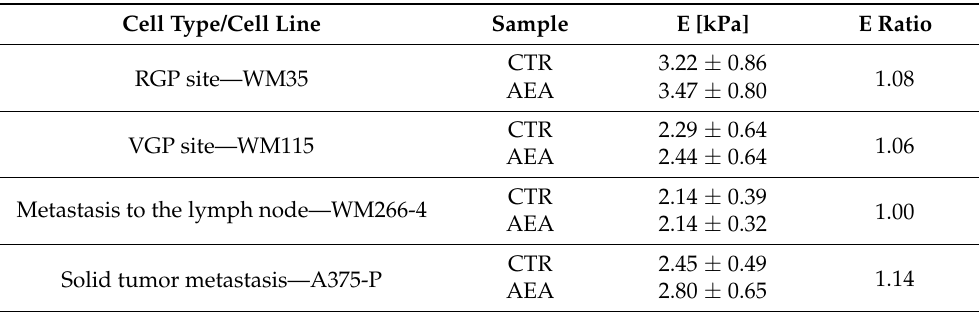
Table 4. Results of the elastic modulus (E) analysis of the AEA-treated melanoma cells received from the AFM